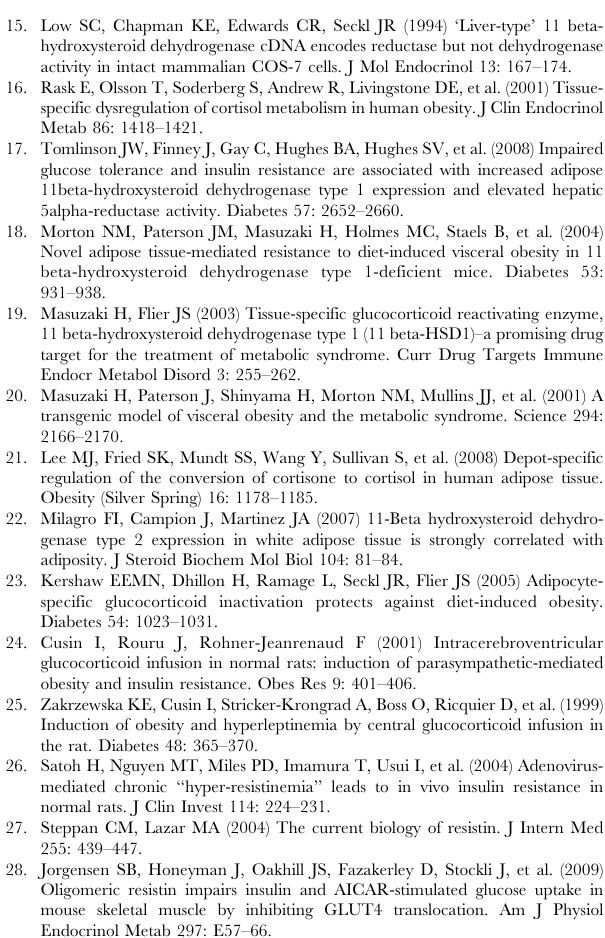
Table S1 Primer sequences used for real-time